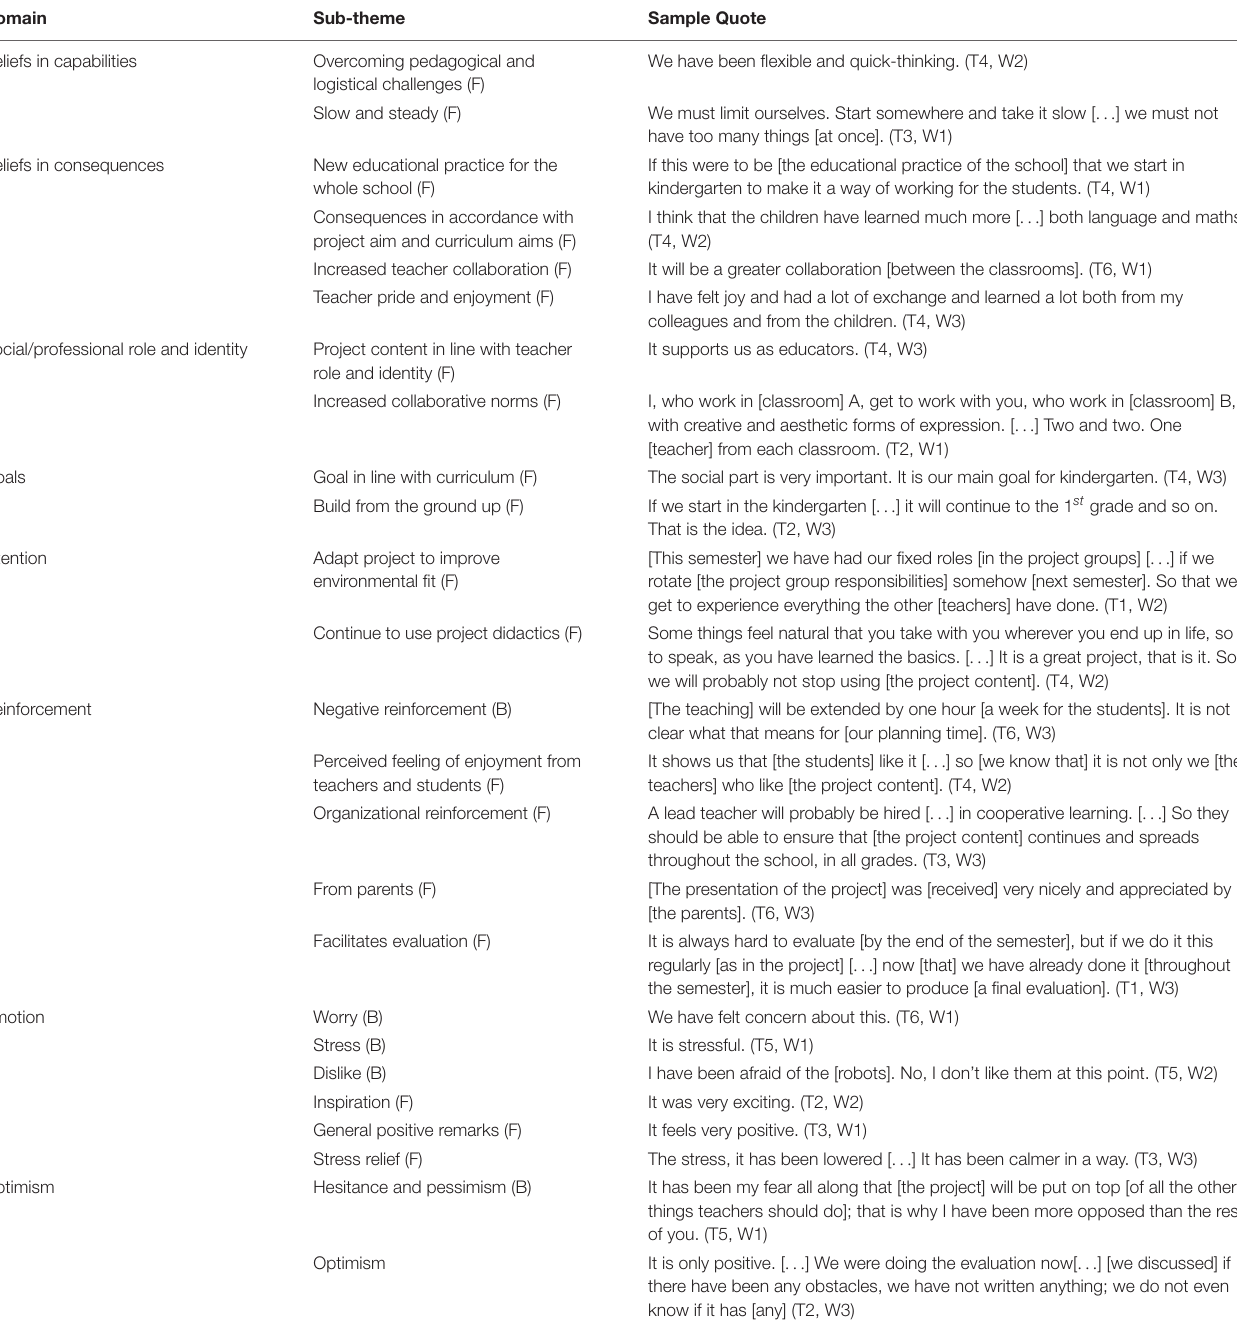
TABLE 3 | Motivation. Domain Sub-theme Sample Quote Beliefs in